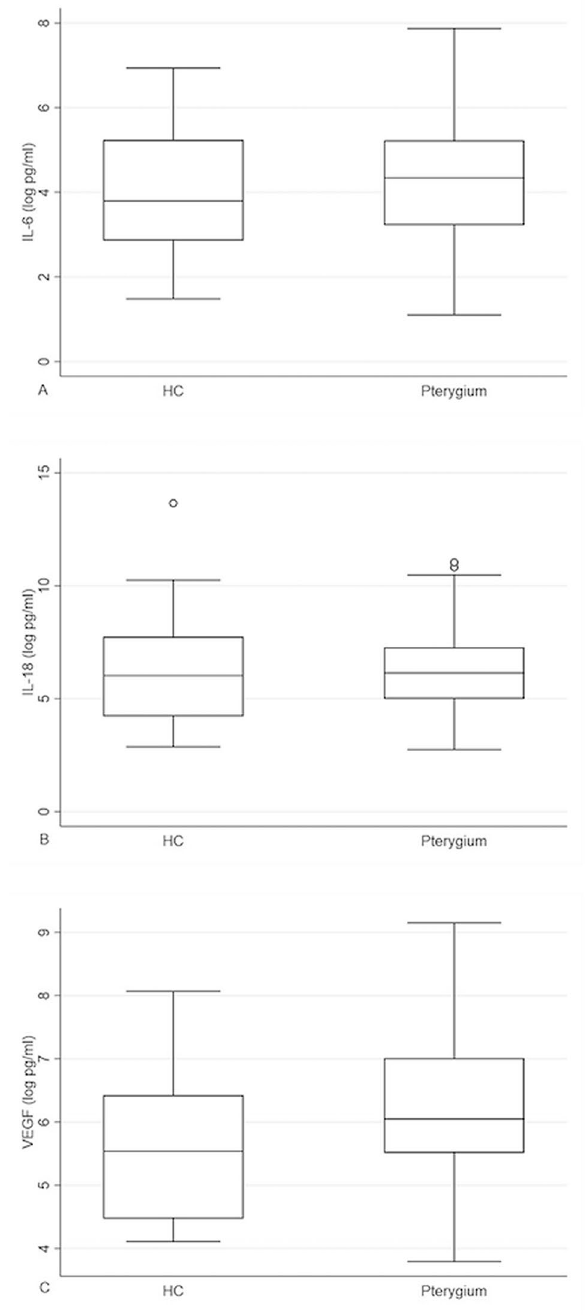
Figure 2. Boxplot of tear cytokine concentration (after logarithmic transformation) in healthy control, and pterygium groups. ( A ) Tear IL-6 concentration in each group; ( B ) Tear IL-18 concentration in each group; ( C ) Tear VEGF concentration in each group with a significantly higher concentration of VEGF in pterygium